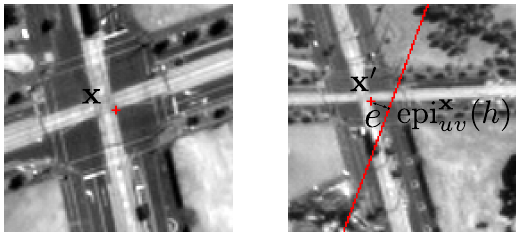
Figure 5: This pair of views of a road intersection highlights the effect of the satellite relative pointing error. Two corresponding points x and x 0 are shown, and the epipolar curve of point x as traced by the RPC doesn’t pass through the corresponding point x 0 . The relative pointing error , denoted by e , is the distance from the point to the epipolar curve. The altitude of the 3-space point corresponding to x and x 0 is approximated by the parameter h for which the epipolar curve passes through the projection of x 0